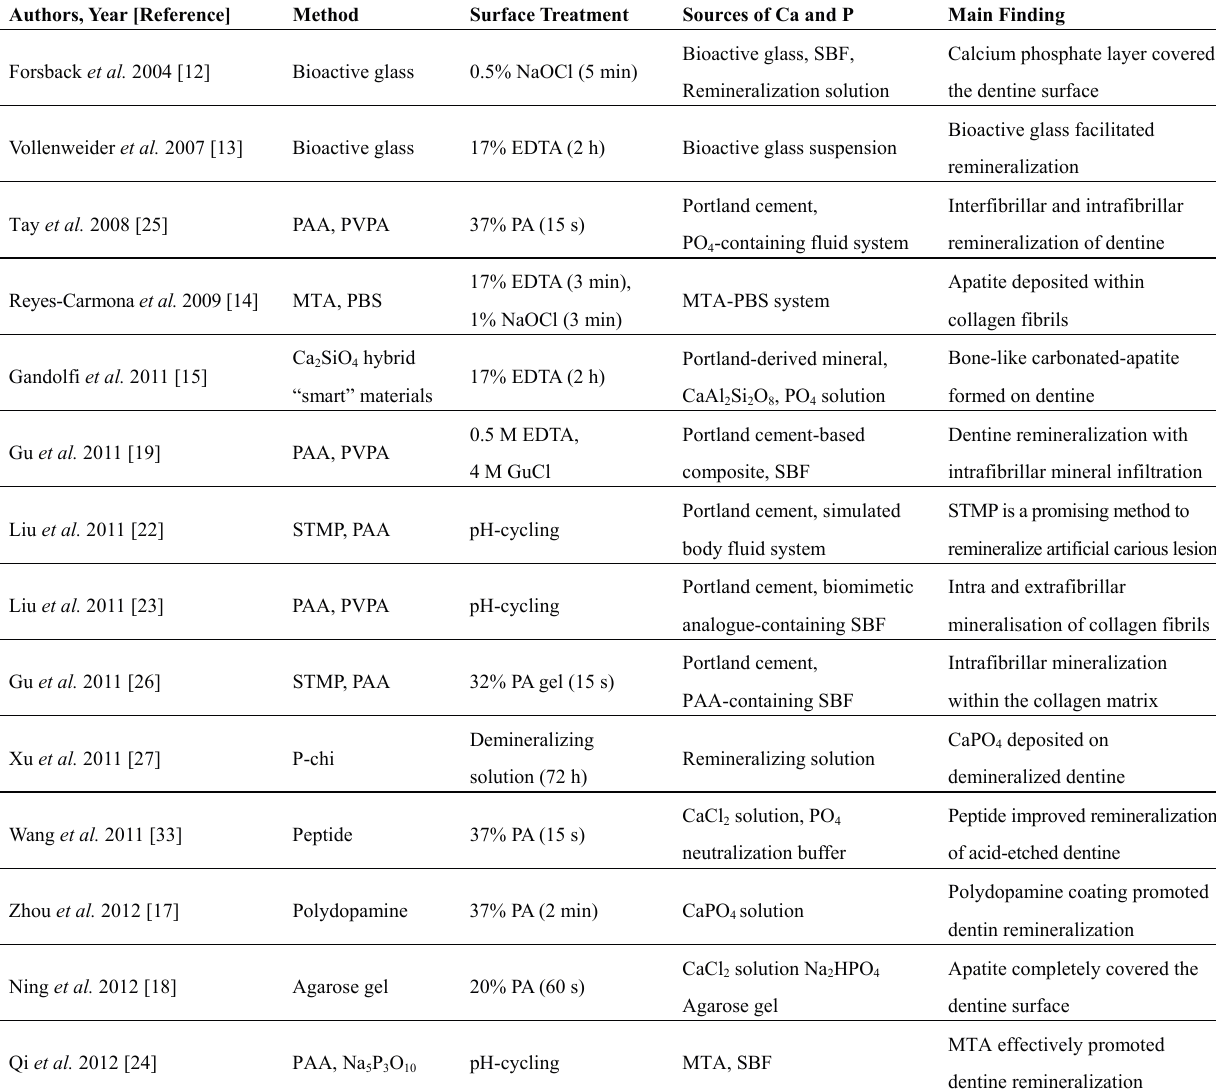
Table 1. Summary of the in vitro studies on biomimetic mineralization on human